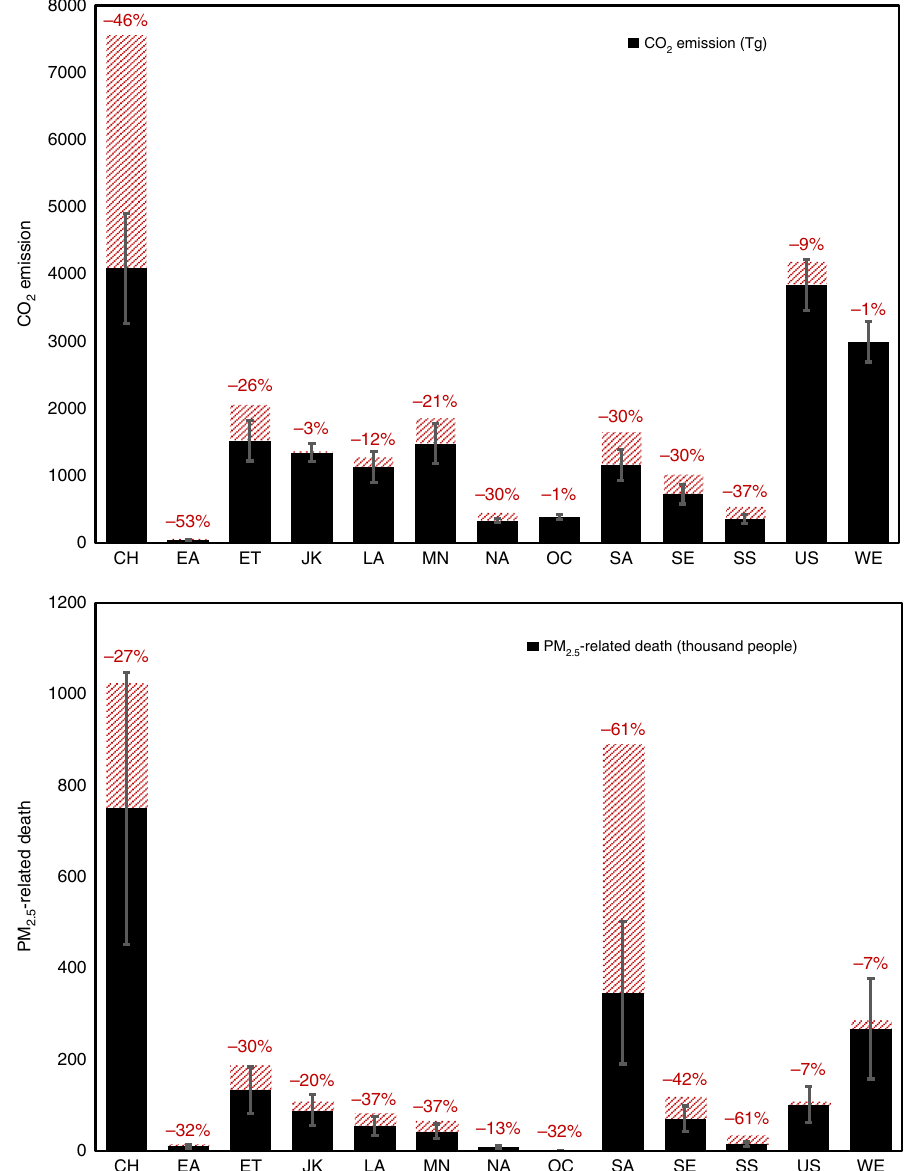
Fig. 4 Regional CO 2 emission, PM 2.5 -related premature mortality under global free trade plus technological/ fi nancial support scenario (GFTT). Error bars denote uncertainty ranges (95% CI). Red dashed bars denote the amounts of respective reductions from global free trade scenario (GFT). Results here only include scenario-dependent sources. Regions, include China (CH), rest of East Asia (EA), Economies in Transition (ET), Japan and Korea (JK), Latin America and Caribbean (LA), Middle East and North Africa (MN), rest of North America (NA), Oceania (OC), South Asia (SA), South-East Asia and Paci fi c (SE), Sub-Saharan Africa (SS), the United States (US), and Western Europe